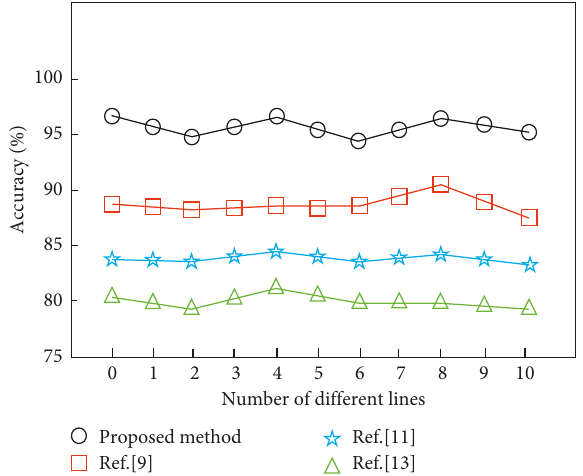
Figure 5: Diagnosis accuracy of different algorithms for pole-to- pole short-circuit